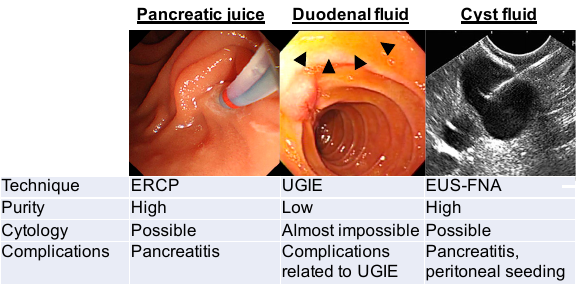
Figure 1. Representative methods to collect pancreatic juice. ERCP: endoscopic retrograde cholangiopancreatography; GIE: gastrointestinal endoscopy; EUS-ENA: endoscopic ultrasonography-guided fine needle aspiration; PJ: pancreatic juice. Black triangle: accumulated duodenal fluid. Scale bar: 1cm